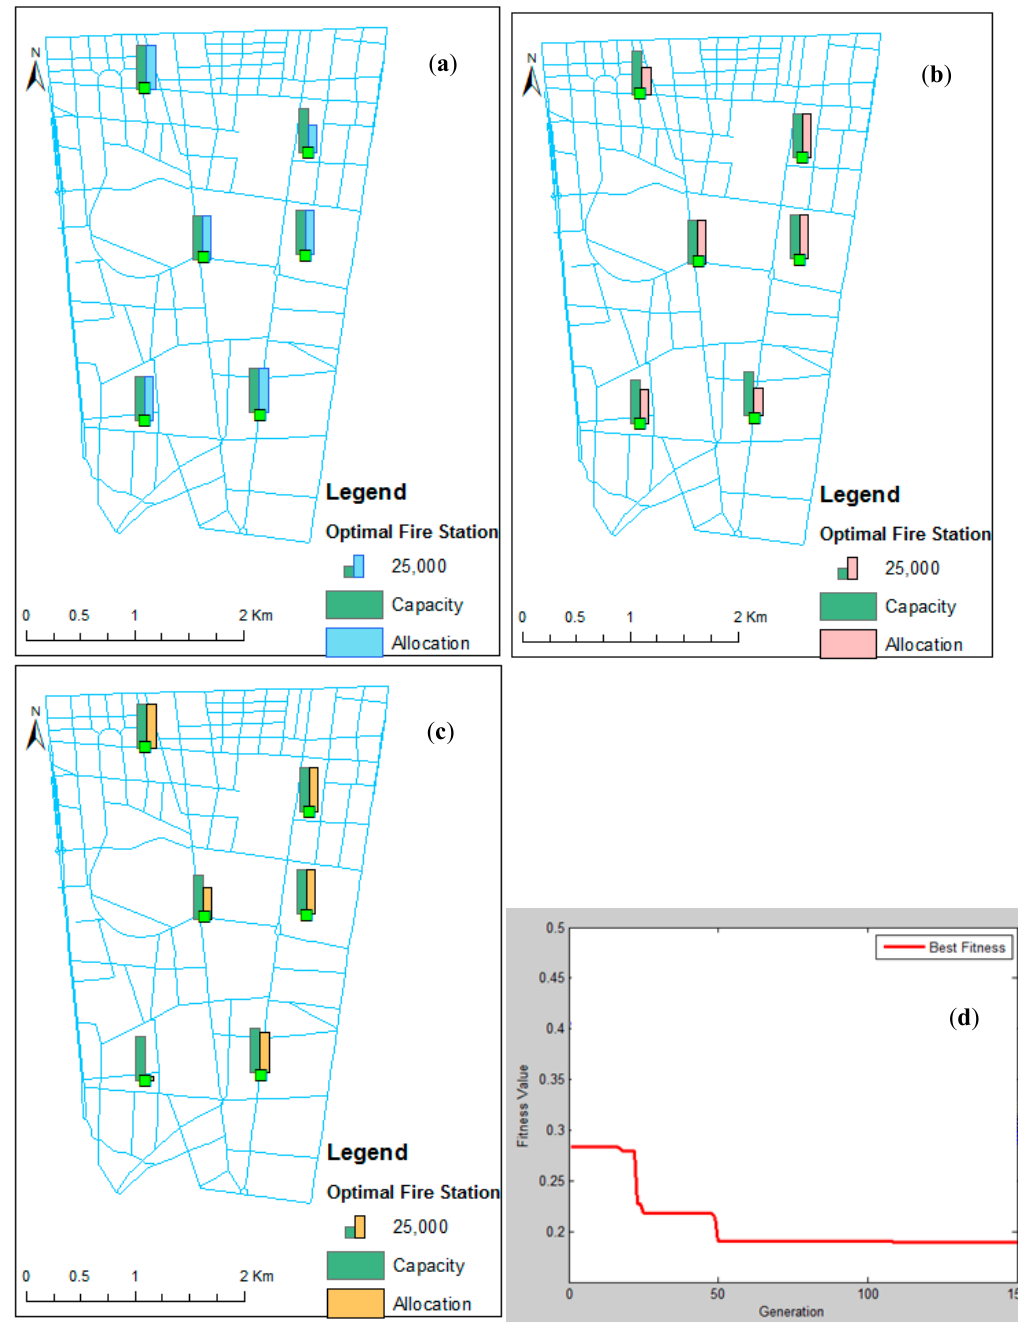
Figure 4. Optimal location of fire stations, their capacity, and allocations in ArcGIS by means of best GA parameters with fixed weights ( W 1 = W 2 = W 3 = 0.3333 ) for functions ( a ) f1, ( b ) f2, ( c ), f3, and ( d ) fitness output graph.